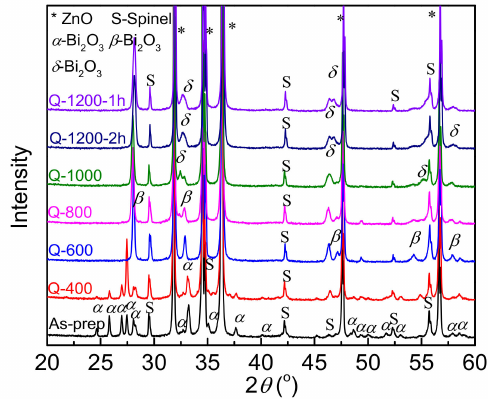
Figure 1. XRD patterns of ZnO ceramic samples quenched at different